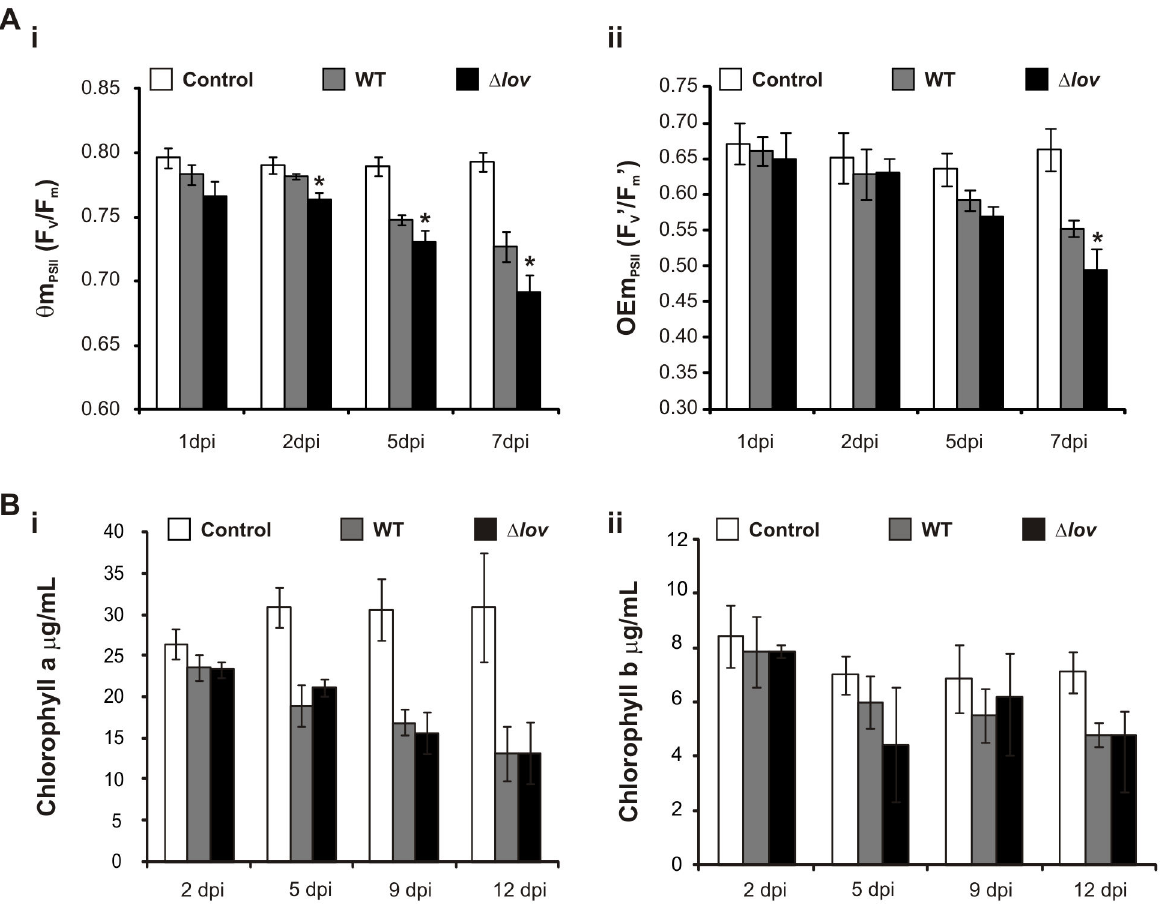
Figure 2. Evaluation of host photosynthesis during Xanthomonas citri subsp. citri interaction with orange leaves. ( A ) Chlorophyll fluorescence parameters were calculated in orange leaves inoculated with the WT and Δ lov X. citri subsp. citri strains and control treatments (10 mM MgCl ) at different days post inoculation (dpi): Φm corresponds to maximum quantum yield of PSII 2 PSII in the dark adapted state (F /F , Ai ), OEm corresponds to maximum operating efficiency of PSII (F’ /F’ , Aii ). F : maximum v m PSII v m m chlorophyll fluorescence in dark adapted leaves; F : variable fluorescence in dark adapted leaves; F ’: maximum chlorophyll v m fluorescence after saturating light pulses, F ’: variable fluorescence after saturating light pulses. ( B ) Chlorophyll a ( i ) and b (ii) v contents were measured at different times after orange inoculation with X. citri subsp. citri WT and Δ lov strains and control treatment. All results are expressed as the mean of three independent biological replicates and error bars represent the standard deviations. Asterisks indicate significant differences between WT and Δ lov treatments (p<0.05). doi: